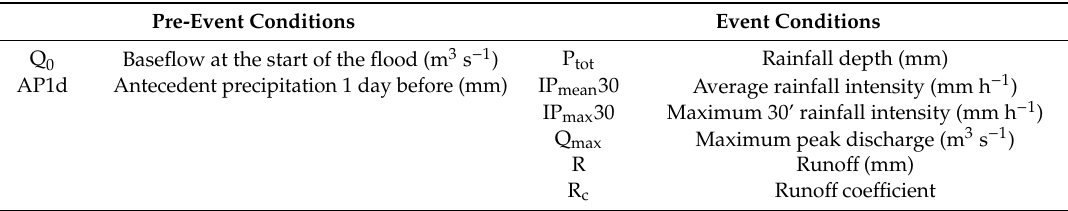
Table 1. Pre-event and event conditions variables to explain the rainfall-runoff relationship in the Es Fangar Creek catchment.